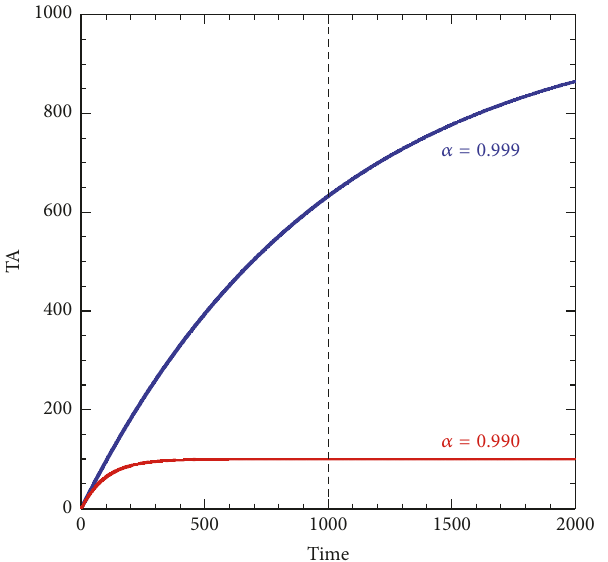
Figure 7: Average hit rate (AHR) as the memory parameter 𝛼 is continuously changed when 𝑃 𝐴 = 0.4 and 𝑃 𝐵 = 0.6 are switched at every 1000 trials. The upper limit of AHR is 0.6 (dashed